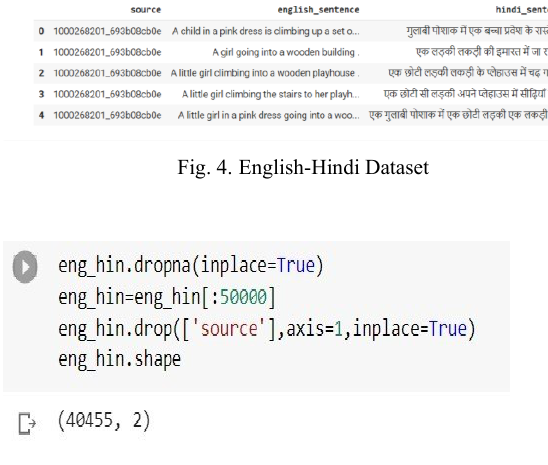
Fig. 5. Total number of captions in the